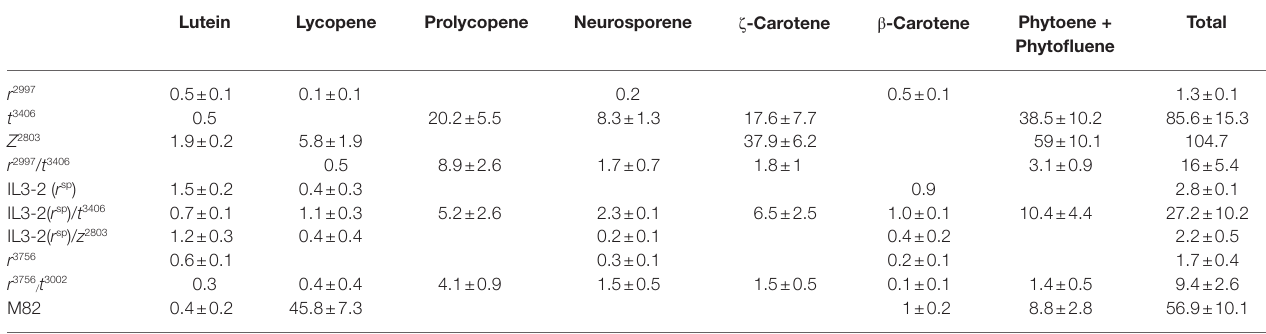
flesh alleles r 2997 , r 3756 , and IL3-2 ( r sp ; Figure 3C ). In compliance